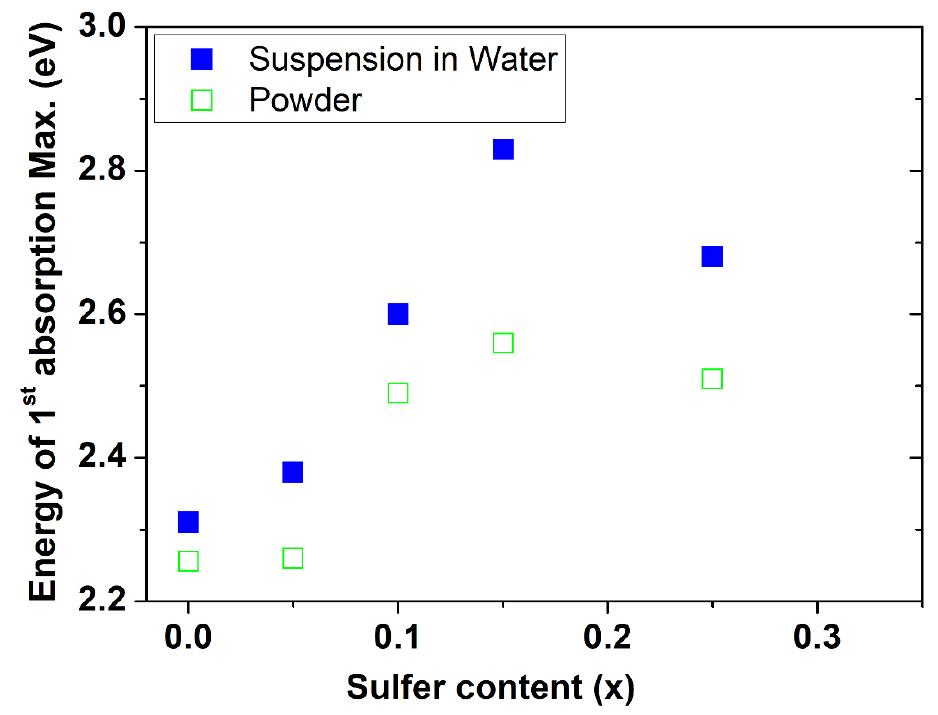
Figure 12. Comparison of the position of the energy of the first absorption maximum for the samples in powder form and dispersed in water.